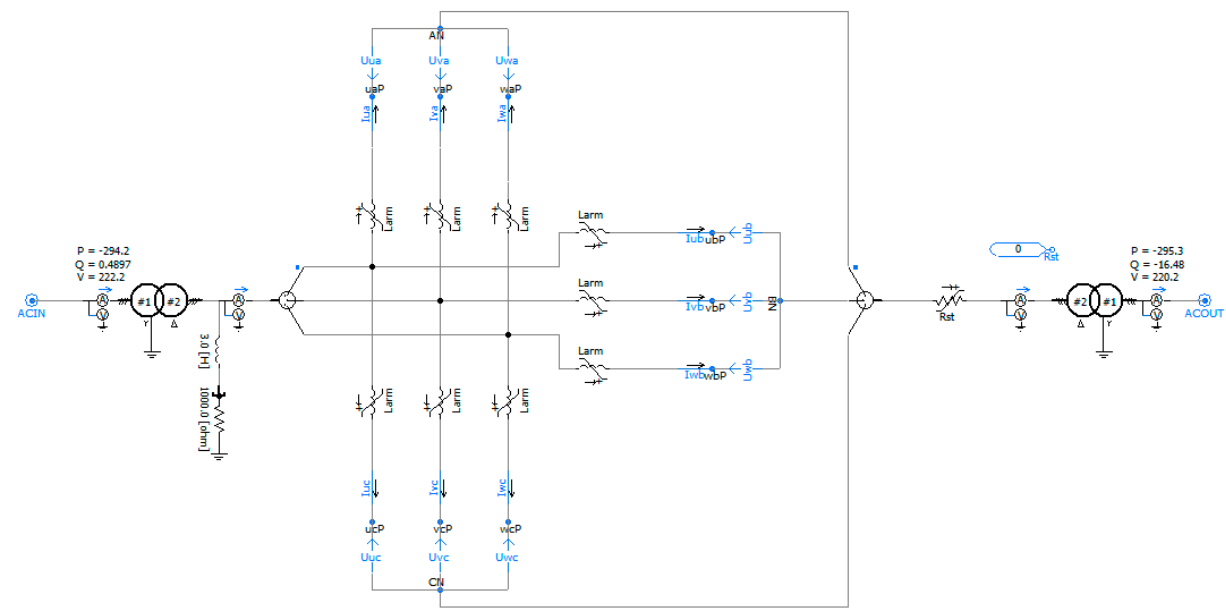
Figure A1. Simulation model of M3C main circuit.